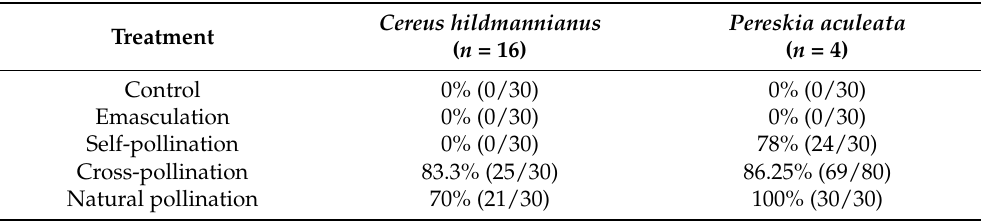
Table 1. Breeding system treatments in Cereus hildmannianus and Pereskia aculeata . Both species are pollinator-dependent since no fruits were obtained either from intact or emasculated flowers. Cereus hildmannianus is self-incompatible and Pereskia aculeata is fully self-compatible ( n = number of individuals; numbers in parentheses represent the number of fruits obtained on the number of flowers used in each